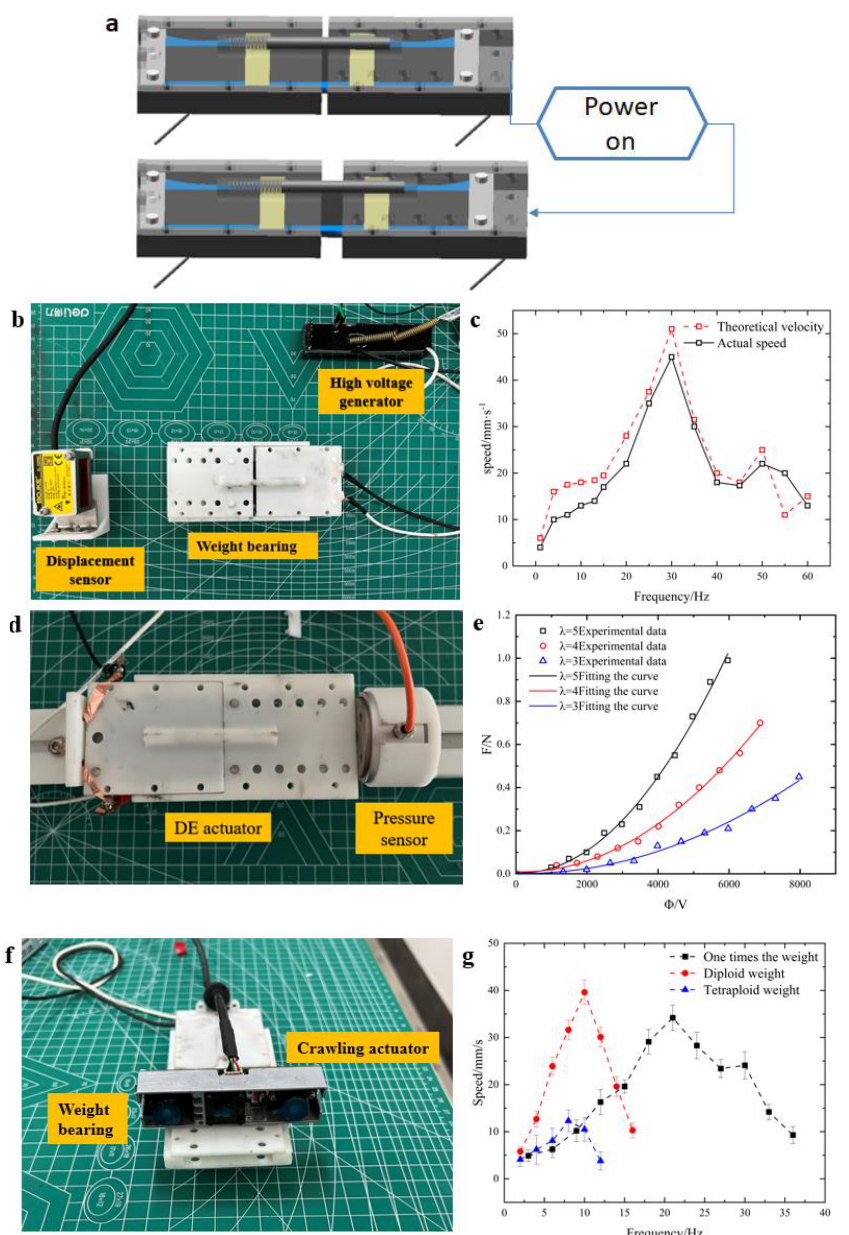
Figure 5. ( a ) Diagram of the actuator after power on. ( b ) The figure shows the measuring device on the actuator. ( c ) The measured data, divided into theoretically calculated data and actual measured data. ( d ) The figure shows the actuator force test device, which is mainly used for measurement with the pressure sensor. ( e ) The graph shows the results of the driving force measurements and their fitted curves. ( f ) The actuator in the picture carries a camera, which acts as a heavy object. ( g ) The figure shows the crawling speed of the robot under different loads; results in the figure show that it maintained good performance even under four times its own weight.